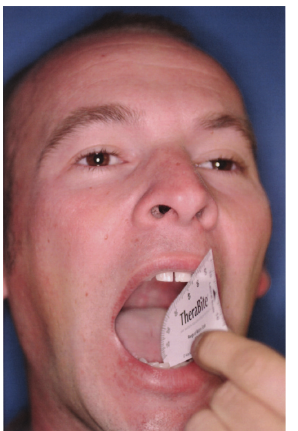
Figure 5: Postoperative interincisal opening of more than